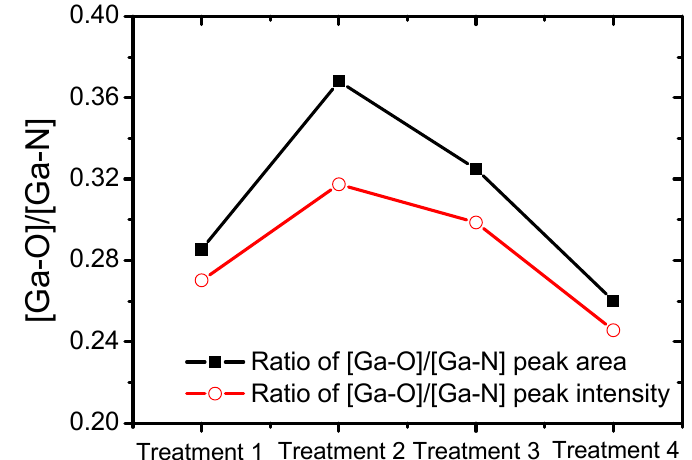
Figure 3. XPS spectra of the Ga3d core levels of the GaN layer after treatments with ( a ) treatment 1, ( b ) treatment 2, ( c ) treatment 3, and ( d ) treatment 4.